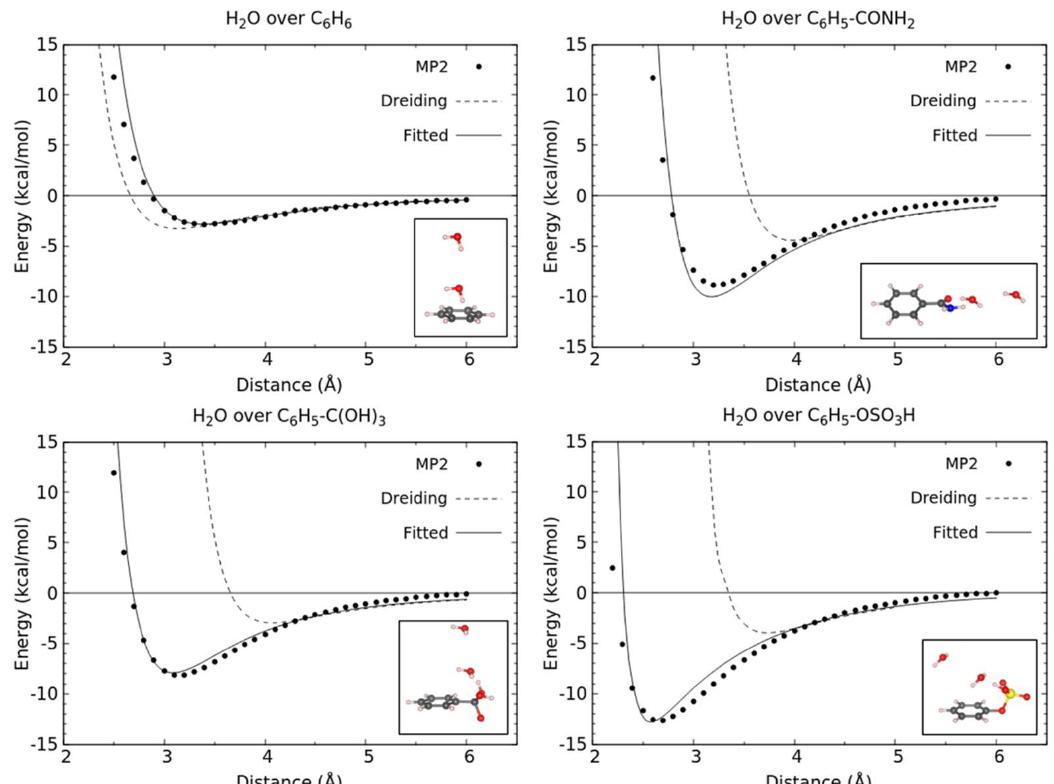
Figure 3. The functionalized linker structure of Mg-MOF-74-III considered in the GCMC simula- tions; the original Mg-MOF-74-III linker ( a ), the –OSO 3 H ( b ), –CONH 2 ( c ) and –C(OH) 3 ( d ) function- alized linker. Carbon, hydrogen, oxygen, sulfur and nitrogen atoms are depicted as grey, pink, red, yellow and blue spheres, respectively.